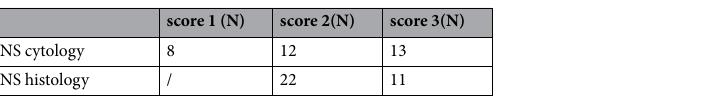
Table 4. Comparison between nuclear score evaluated on cytological smear and nuclear score evaluated on histological fomalin-fixed paraffin-embedded (FFPE) sections. Abbreviations: NS = nuclear